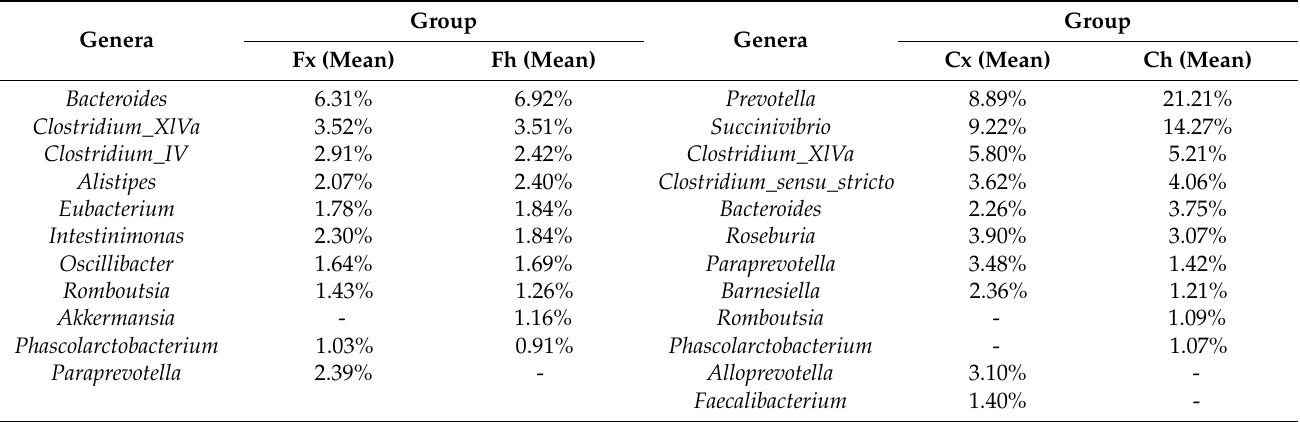
Table 1. The relative abundance of the first 10 genera expressed as the percentage of the total microbial abundance of free-range yaks ( n = 18) and captive yaks ( n =